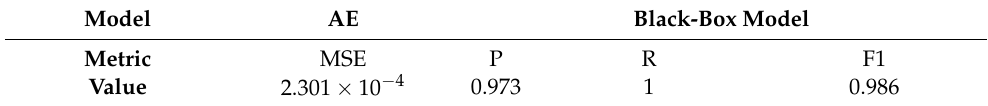
Table 4. Results obtained with the autoencoder and the black-box model f ( · ) .